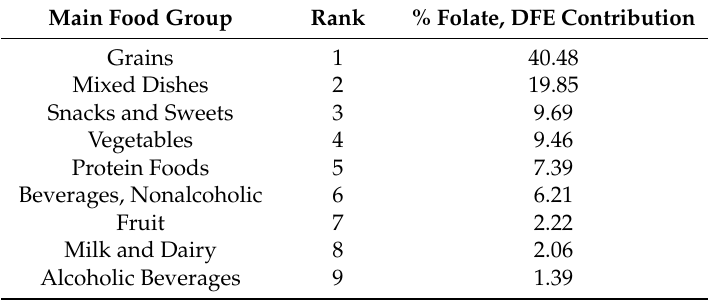
Table 7. Food sources of folate, DFE, contribution in the total U.S. diet, adults ≥ 51 years old ( n = 4522; gender combined; daily intake data; NHANES 2011–2014; DFE = dietary folate equivalents; main food groups contributing <1.0% not reported; data are Day 1